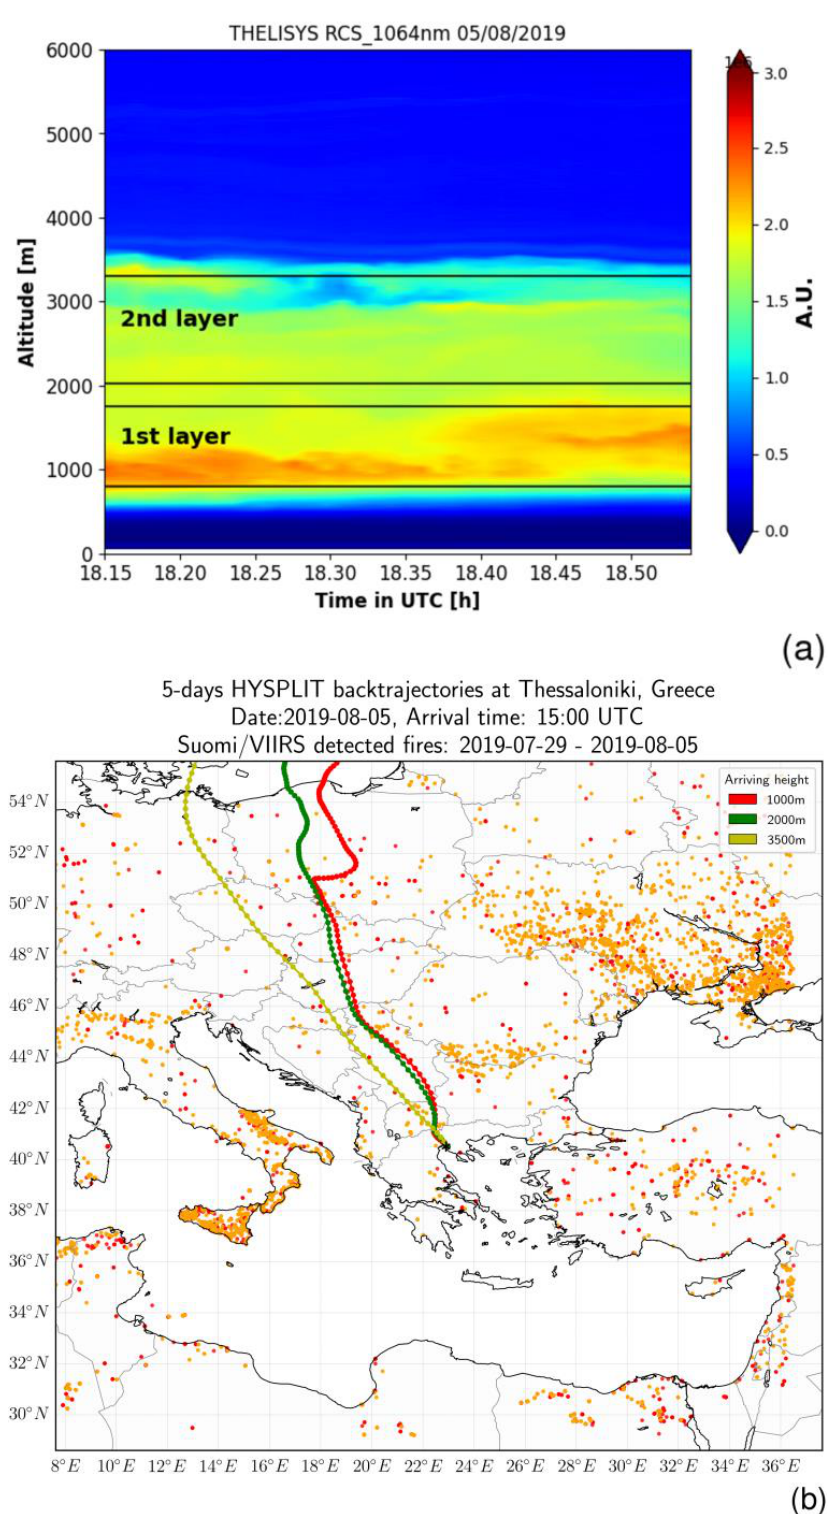
Figure 10. ( a ) Temporal evolution of the 1064nm range corrected signal obtained with THELISYS in Thessaloniki on 5 August 2019, 18:15 – 18:50 UTC. The two layer boundaries are marked with black line. ( b ) The HYSPLIT 5-day air mass backward trajectories arriving at 1, 2 and 3.5 km at 15:00 UTC at Thessaloniki.